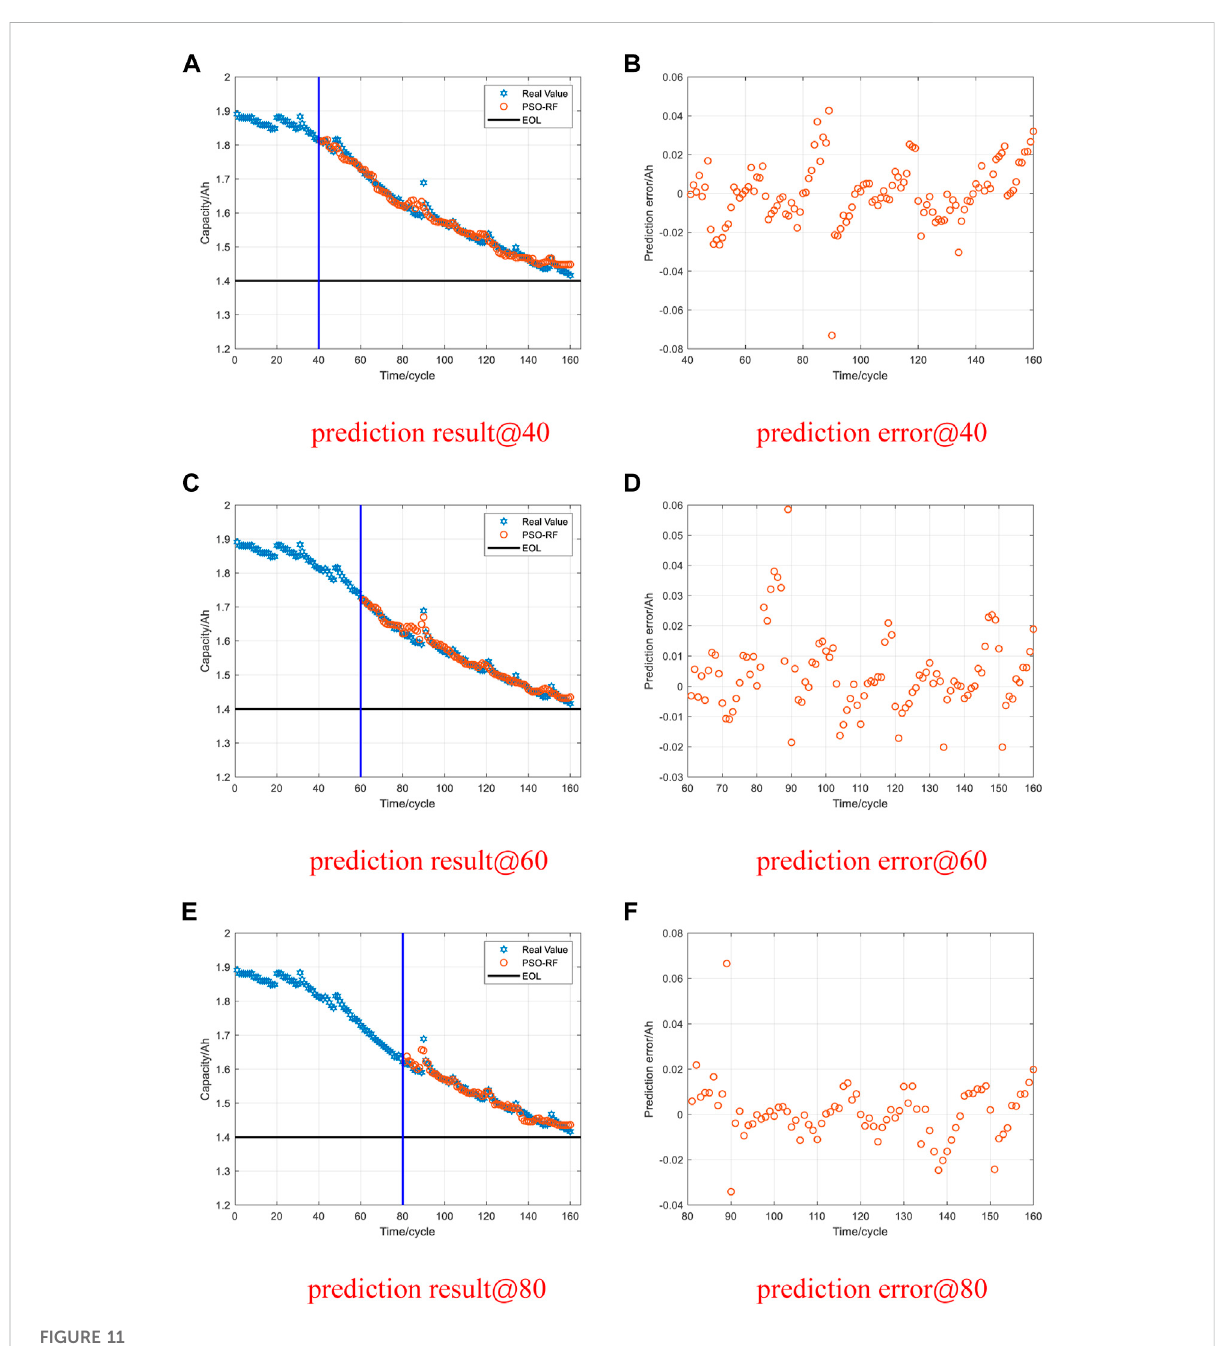
FIGURE 11 Results and errors of B0007